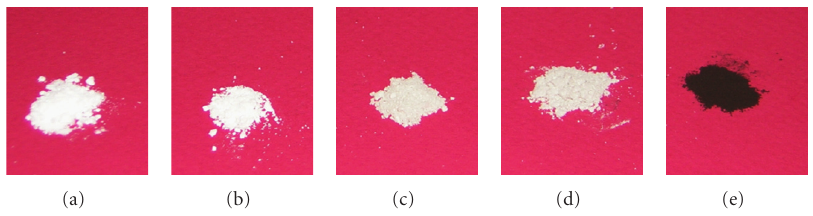
Figure 4: Pictures of particles produced by the modified-PGSS process starting from: (a) triestearin, (b) triestearin + 1% magnetite, (c) triestearin + 5% magnetite, (d) triestearin + 10% magnetite, and (e) magnetite powder. Table 3: Light Scattering measurements on the lipid nano- and